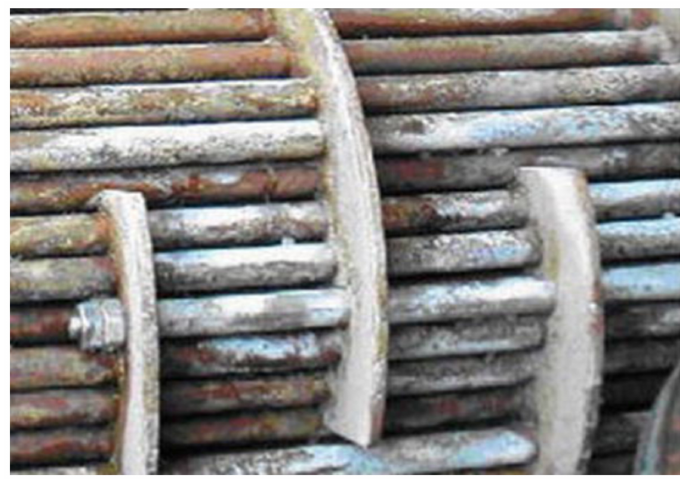
Figure 3. Accumulation of precipitated salts in heat exchanger tubes